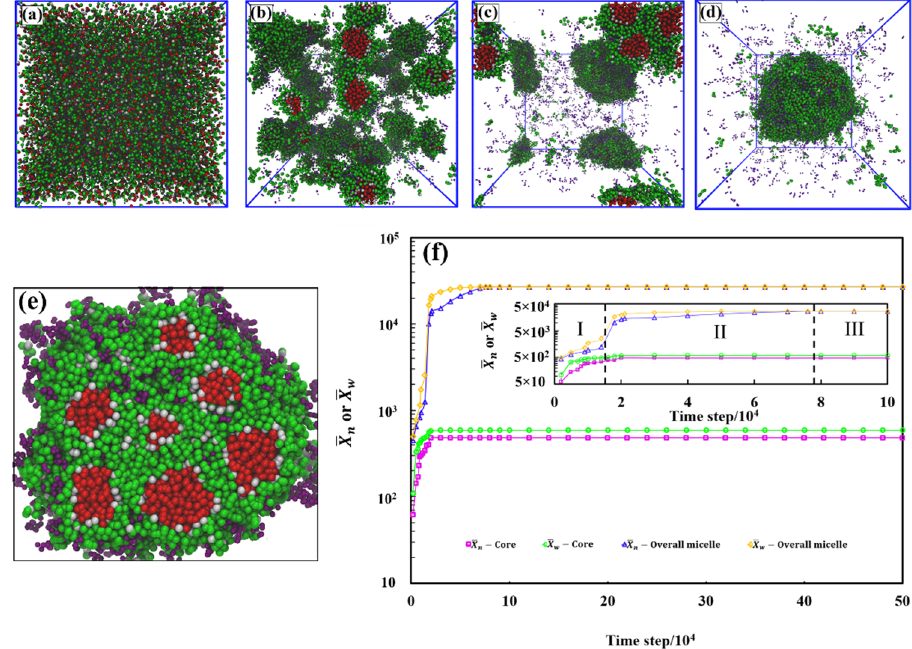
Figure 2. Spontaneous aggregation in a system consisting of A 19 (4%), A 1 - b -S 6 (13%), and S 6 (3%) in a simulation system of size (40R c ) 3 . An initially random mixture (panel a ) evolves in 5.0 × 10 5 steps into a spherical multicore assembly (panel d ). The snapshots correspond to simulation times ( a ) zero, ( b ) 4 × 10 3 , ( c ) 1.3 × 10 5 , and ( d ) 5.0 × 10 5 steps. Panel ( e ) shows the cross-section of the multicore assembly formed and ( f ) the dependence of the average particle number and the weight average on time. The inset shows magnification of panel ( f ) at early times, where the different stages of evolution, I–III (stage (I) core and micelle formation, stage (II) small micelle aggregation, and stage (III) equilibration) are discussed in the text. Simulation data standard deviations after equilibration are smaller than the symbol size, and hence no error bars are explicitly presented. The polymer bead colors follow Figure 1. Solvent is omitted in the visualizations for clarity.